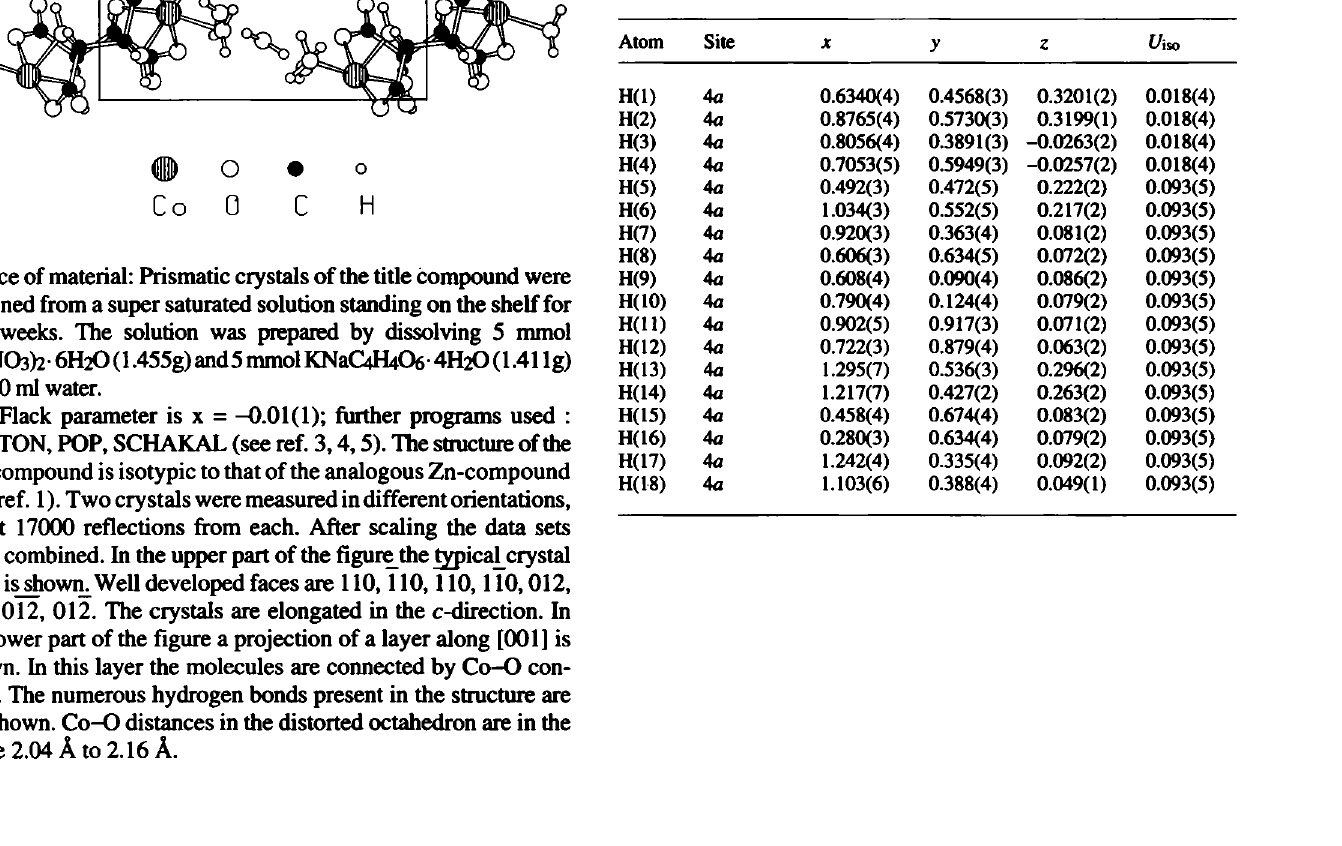
Table 2. Final atomic coordinates and displacement parameters (in Â 2